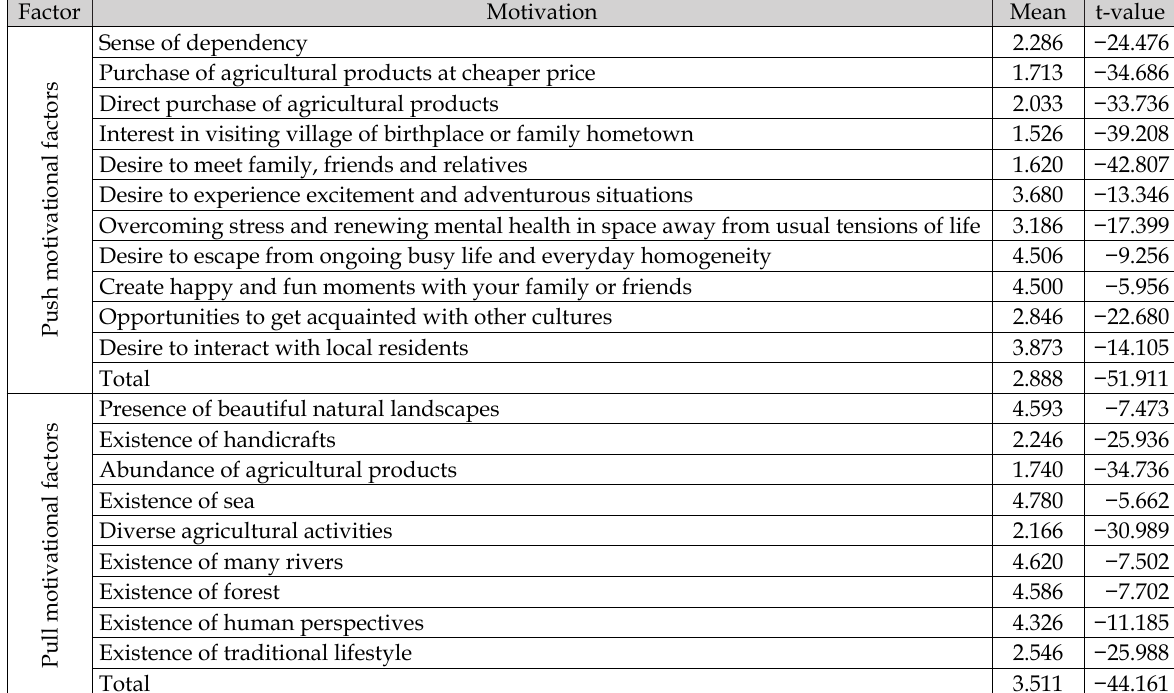
Table 4. One sample T-tests between push and pull motivational